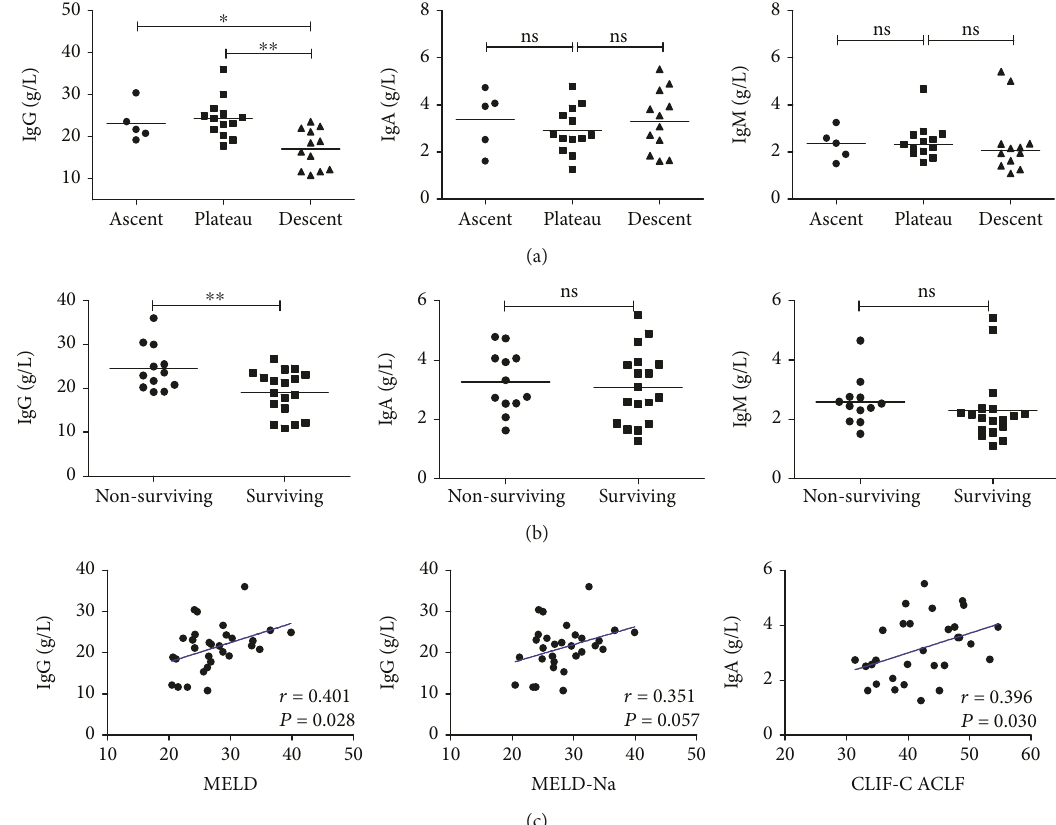
Figure 3: IgG levels were closely associated with disease severity in HBV-ACLF patients. (a) IgG levels were signi fi cantly lower in HBV-ACLF patients at the descent stage than patients at the ascent stage ( P = 0 022 ) and patients at the plateau stage ( P = 0 001 ). However, no signi fi cant di ff erences existed in IgA or IgM levels among HBV-ACLF patients at di ff erent stages. (b) Serum IgG levels were signi fi cantly higher in nonsurviving HBV-ACLF patients than in surviving patients ( P = 0 007 ). Also, we noticed that serum IgM levels were slightly higher in nonsurviving HBV-ACLF patients than in surviving patients ( P = 0 079 ). (c) Positive correlations were found between IgG levels and MELD score, between IgA levels and CLIF-C ACLF score. And a positive correlation trend was found between IgG levels and MELD-Na score. ∗ P < 0 05 ; ∗∗ P < 0 01 ; ns: not signi fi cant; solid line: linear growth trend; r : correlation coe ffi